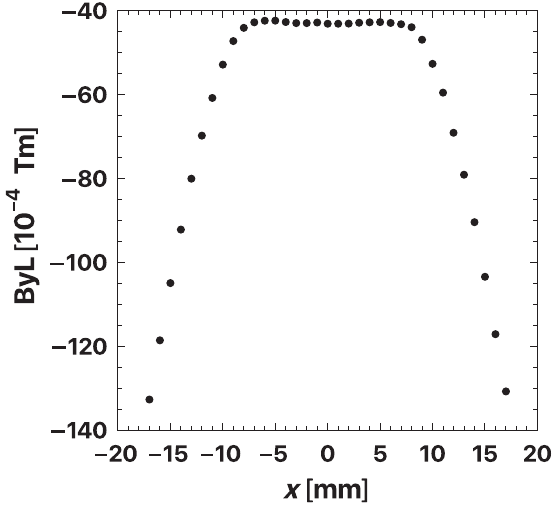
FIG. 6. Integrated magnetic field distribution for the horizontal axis when the ceramic chamber is inserted into the magnetic bore.